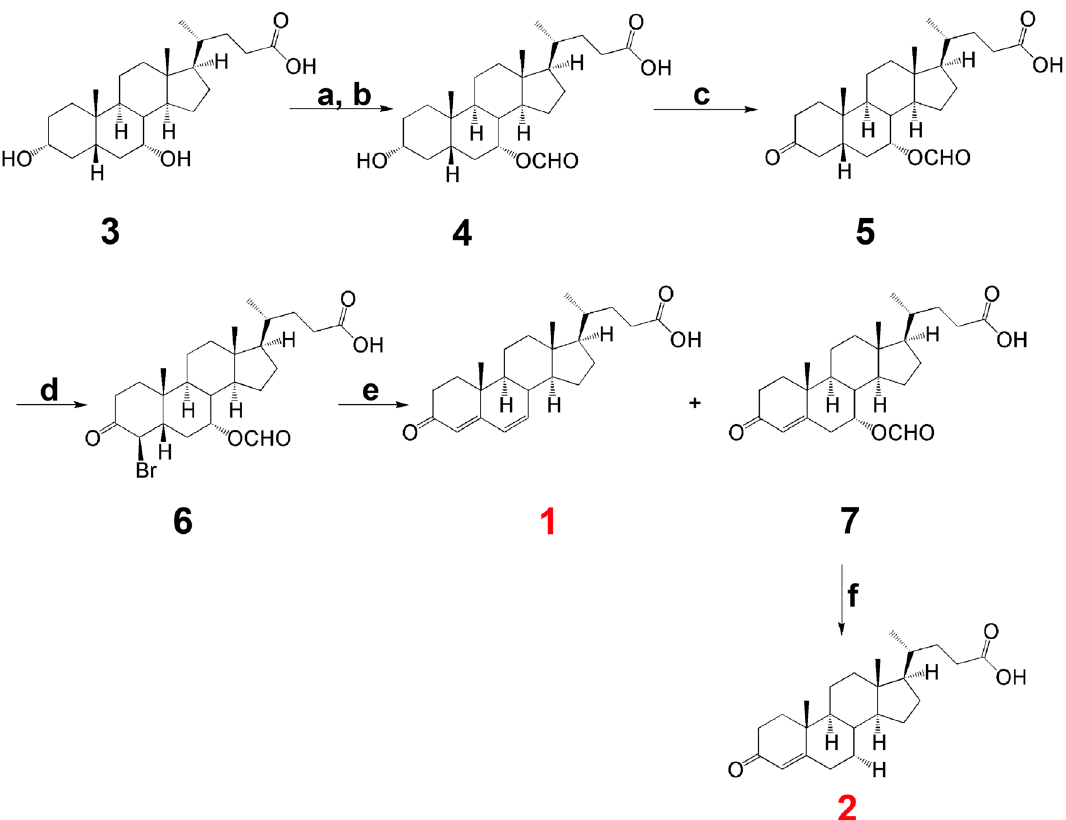
Figure 5. Chemical synthesis of fetal bile acids. Reagents and conditions: a. HCOOH, 70% HClO 4 , 40–60 °C, 2 h; b. 0.2 M NaOH, acetone, RT, 1 h; c. Jones’ reagent, acetone, 0 °C, 2 h; d. PTSA, Br 2 , DMF, RT, 12 h; e. semicarbazide, NaOAc in H 2 O, AcOH, 60 °C, 1 h; f. 0.2 M NaOH, H 2 O, RT, 0.25 h. The reactions were modified from the procedures of Leppik for cholic and deoxycholic acids 31